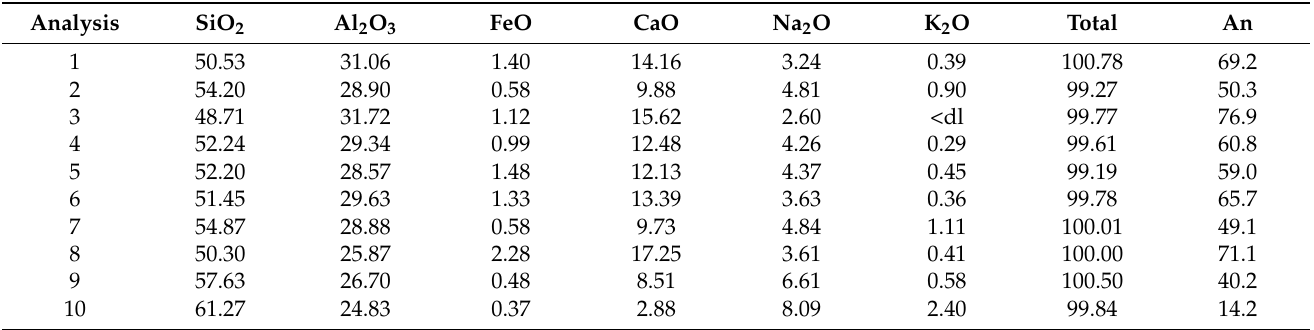
Table 3. Major element composition (by SEM-EDS) of plagioclase from the Ust’-Sema Formation and the Barangol Complex rocks, Gorny Altai.